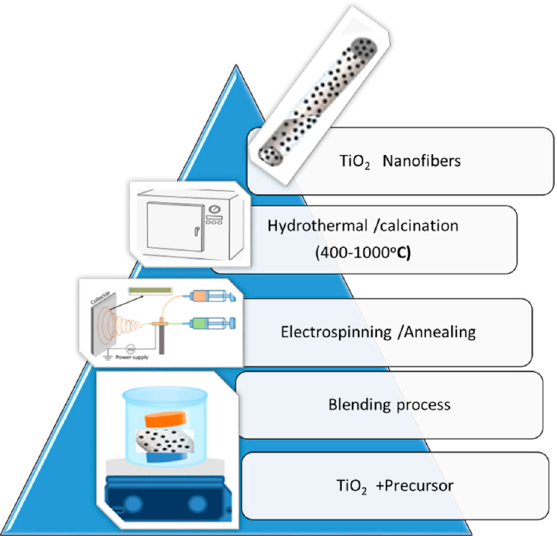
Figure 6. Schematic modification of TiO 2 nanofibers using electropinning and hydrothermal tech- niques; adapted from [98,100].